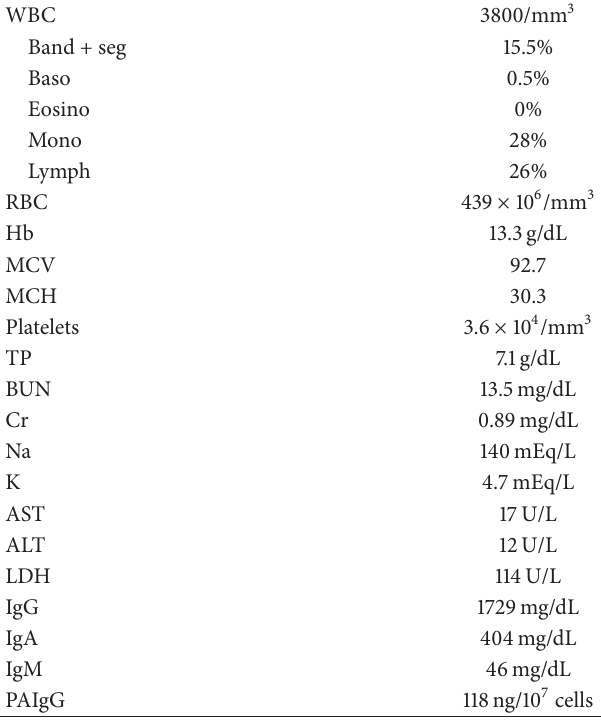
PAIgG: platelet-agglutinated